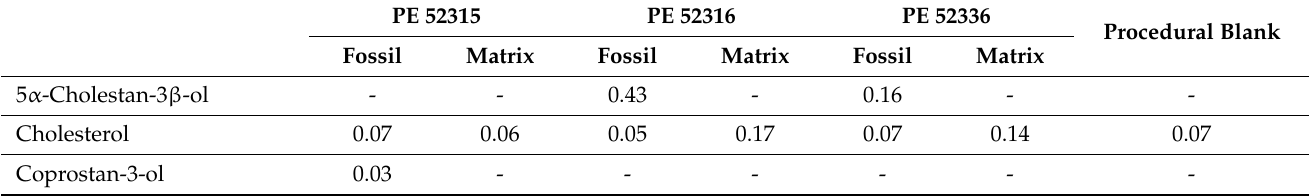
Table 2. Values of sterol compounds reported as total amount in micrograms ( µ g) total in each fraction, quantified against external sterol standards in 500 mL, as an average of two measurements.